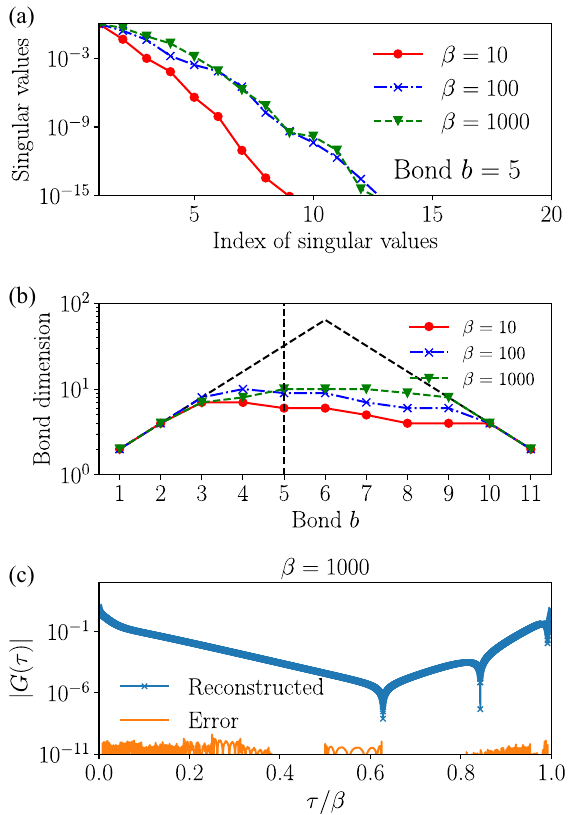
FIG. 6. Compression of G ð τ Þ generated by randomly chosen 100 poles with R ¼ 12 (see the text). (a) Singular values at b ¼ 5 , (b) bond dimensions for ϵ ¼ 10 − 20 , (c) comparison between the exact and reconstructed data. G ð τ Þ has three sign changes. In (b), the dashed line indicates the maximum bond dimensions in maximally entangled cases.